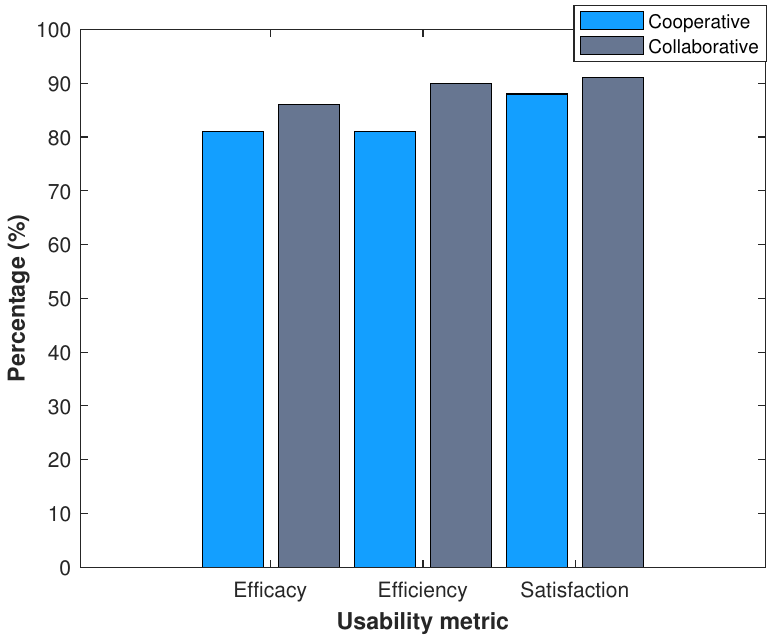
Figure 5. Measurement of usability